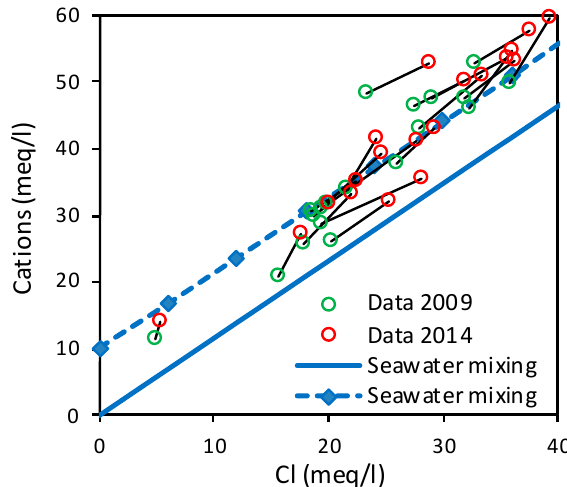
Figure 3. Plot of the total cation concentration versus the chloride concentration and the theoretical mixing line between fresh groundwater and seawater (solid line) or between groundwater with an initial ion content of 20 meq/L and no chloride and seawater (dotted line, the markings indicate intervals of 1% increase in sea water mixing).